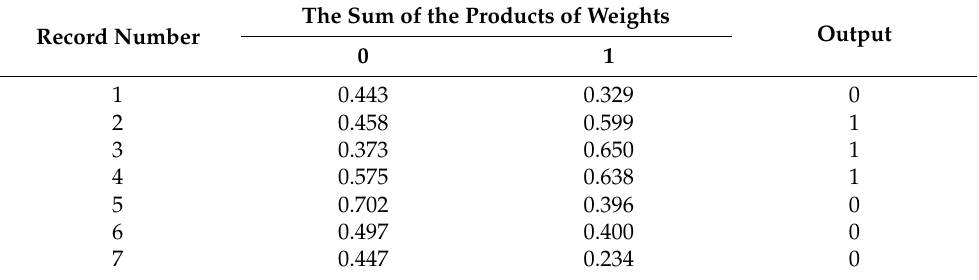
Table 13. Part of the results obtained after